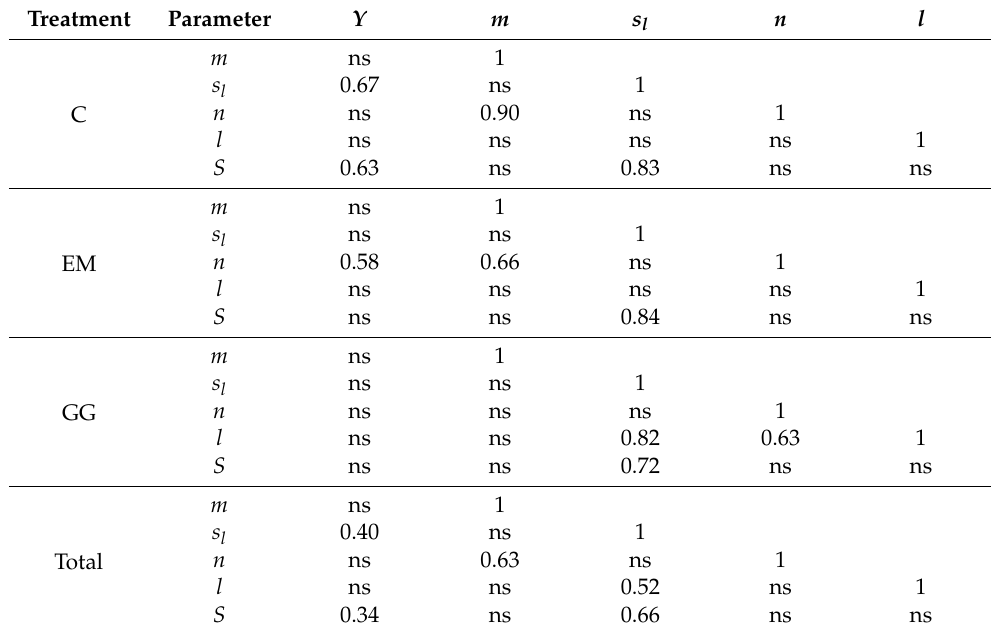
Table 10. Coefficients of Pearson’s correlation between the morphological parameters of shallot plants. Treatment Parameter Y m s l n l m ns 0.67 n ns C